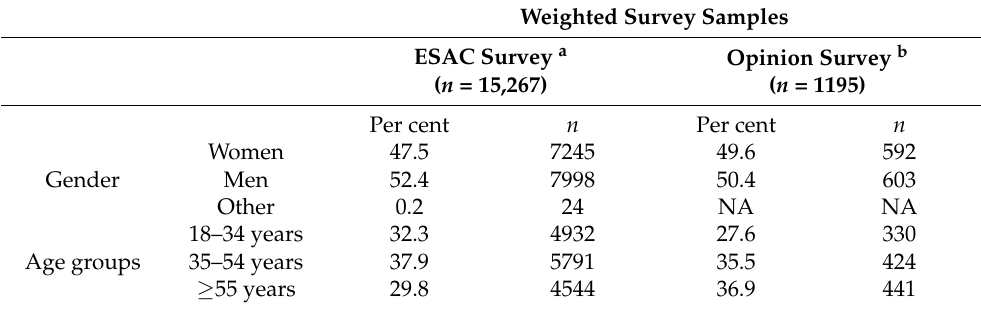
Table 1. Description of analytical survey samples by age and gender distribution.